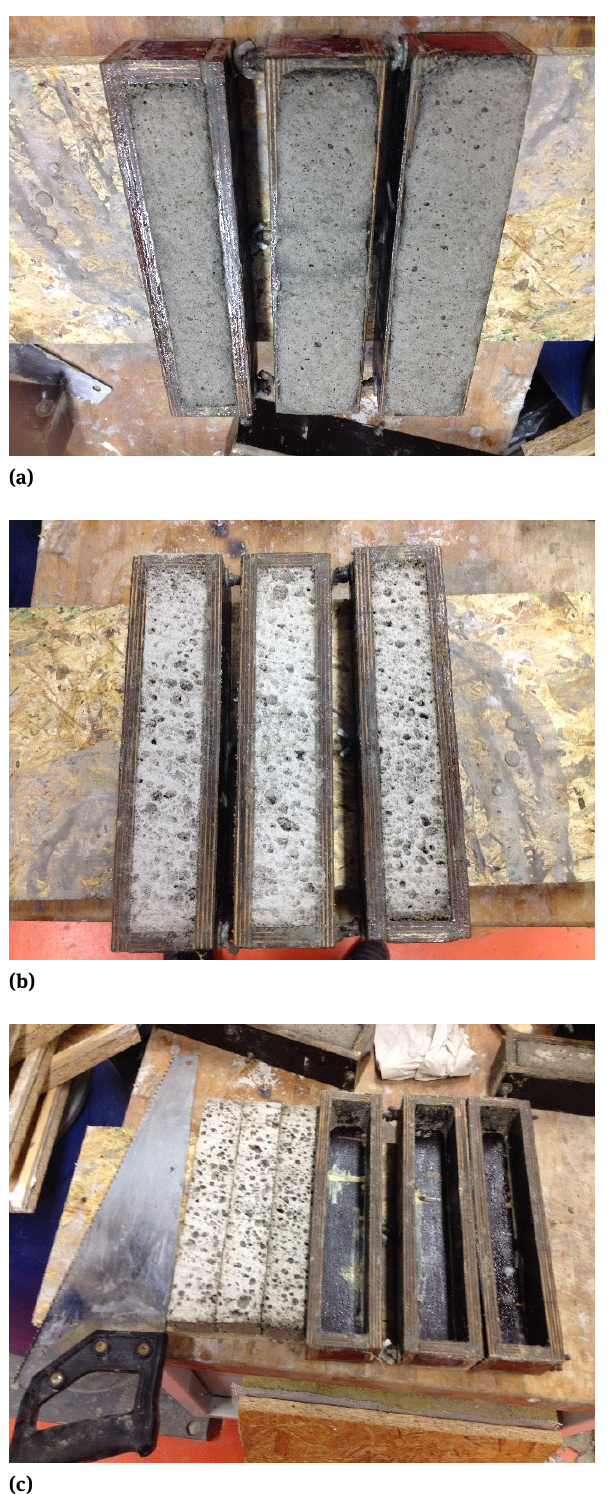
Figure 4: Prepared samples: a) in moulds of size 40 × 40 × 160 mm, b) after cut by hand-saw c) samples removed from